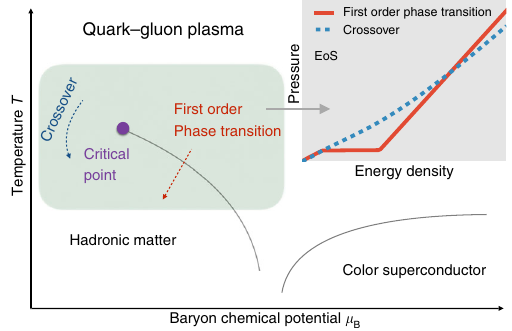
Fig. 1 The conjectured phase diagram in quantum chromodynamics. In the region with high temperature and small baryon chemical potential, the phase transition between hadronic matter and quark – gluon plasma is a cross over according to lattice QCD calculations (blue dashed line in the small insert). In the region with low temperature and moderately high baryon chemical potential, the phase transition is fi rst order (red line in the small insert). At low temperature and high baryon chemical potential, there might exist other phases, such as color